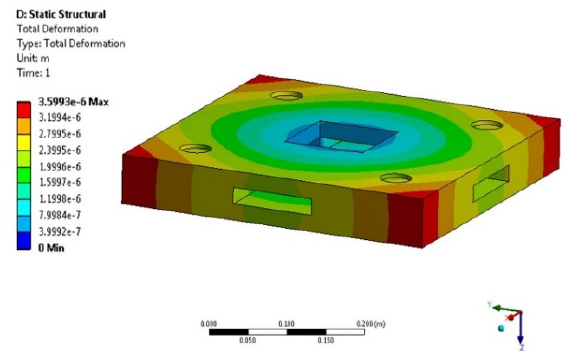
Figure 6. Maximum deformation for initial geometry.